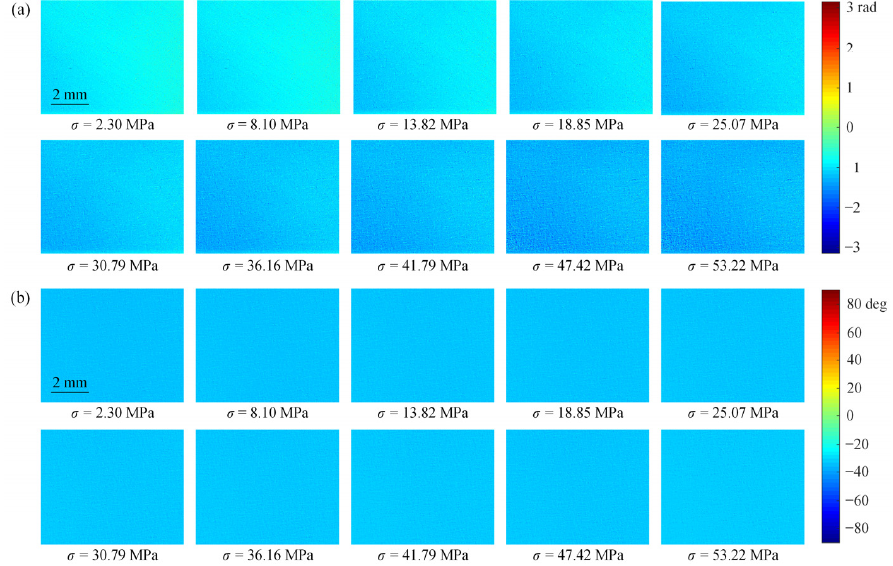
Figure 4. The full-field ( a ) isochromatic phase and ( b ) isoclinic angle distribution of the PET specimen with ϕ = − 15 ◦ obtained in the reflection photoelastic experiment.